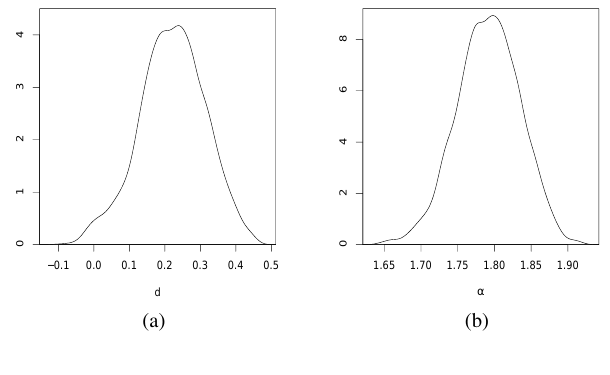
Figure 9. Marginal posterior densities (a) d , (b) α from the model Eq.